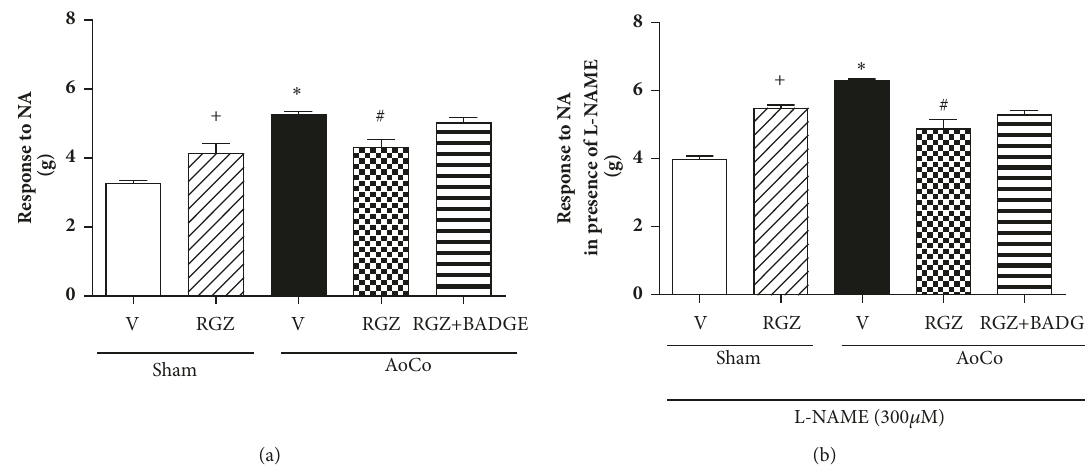
Figure 1: Effect of rosiglitazone (RGZ) on noradrenaline (NA)-induced aortic reactivity in absence (a) or presence (b) of N( 𝜔 )-nitro-L- arginine-methyl-ester (L-NAME, 300 𝜇 M). The values represent the mean ± SEM (n=6 animals per group). One-way analysis of variance (ANOVA) post Tukey. + P < 0.05 sham-V vs. sham-RGZ, ∗ P < 0.05 sham-V vs. AoCo-V, # P < 0.05 AoCo-V vs.